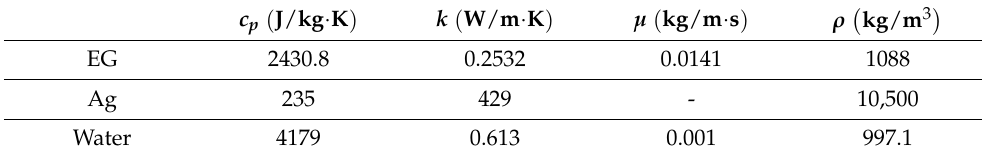
Table 1. The basic properties of the base fluid and eco-friendly NPs